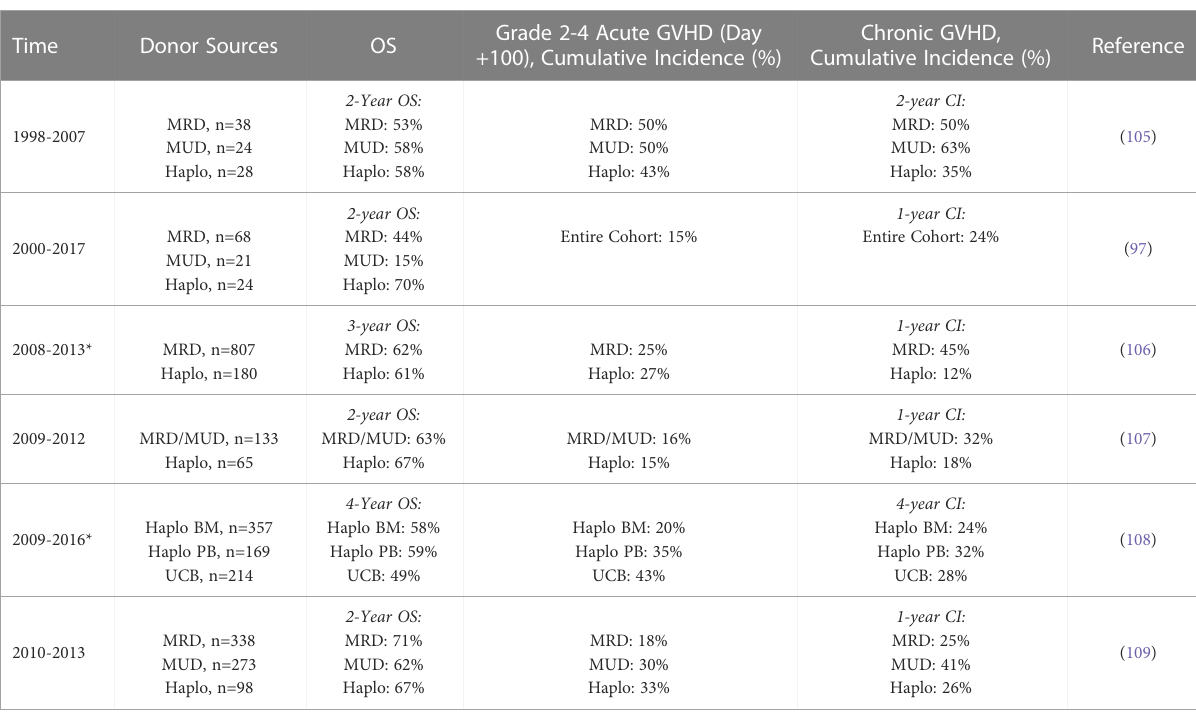
GVHD, Graft-Versus-Host Disease; OS, Overall Survival; MRD, matched related donor; MUD, matched unrelated donor; Haplo, haploidentical donor; BM, bone marrow; PB, peripheral blood; UCB, umbilical cord blood. *Analysis also included patients with